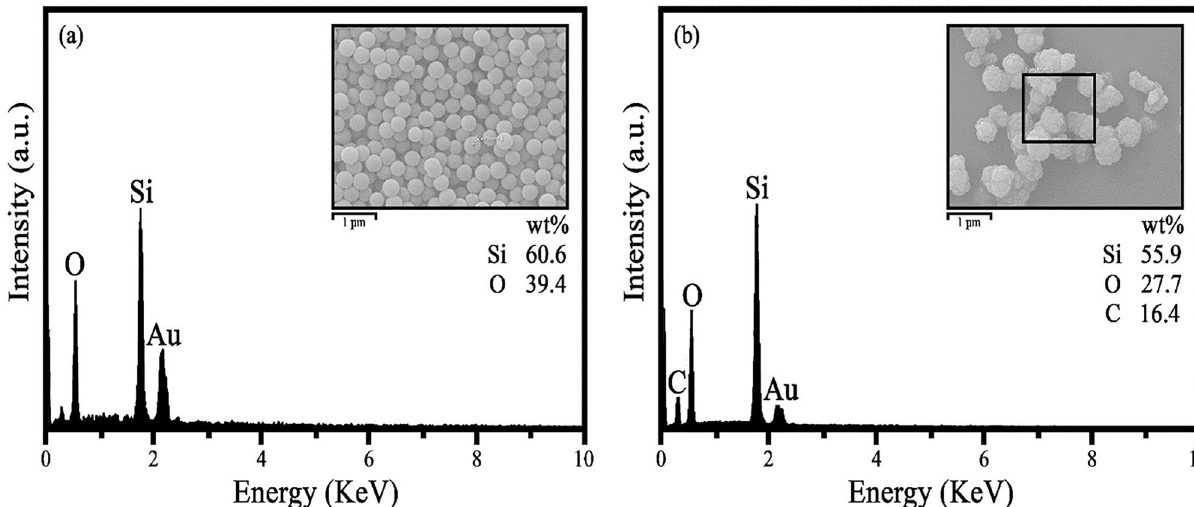
Figure 10. EDS for the ( a ) optimized sample and ( b ) glass surface.